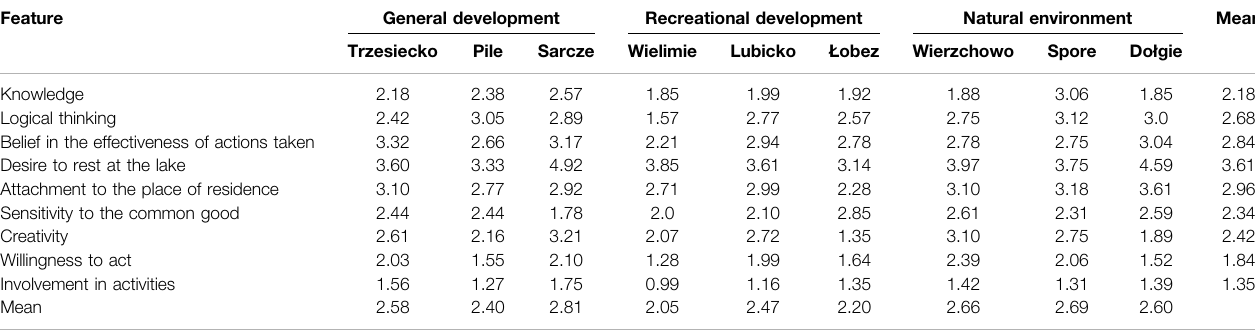
TABLE 2 | Average values of respondents ’ features compared to the lakes selected by the respondents. Feature